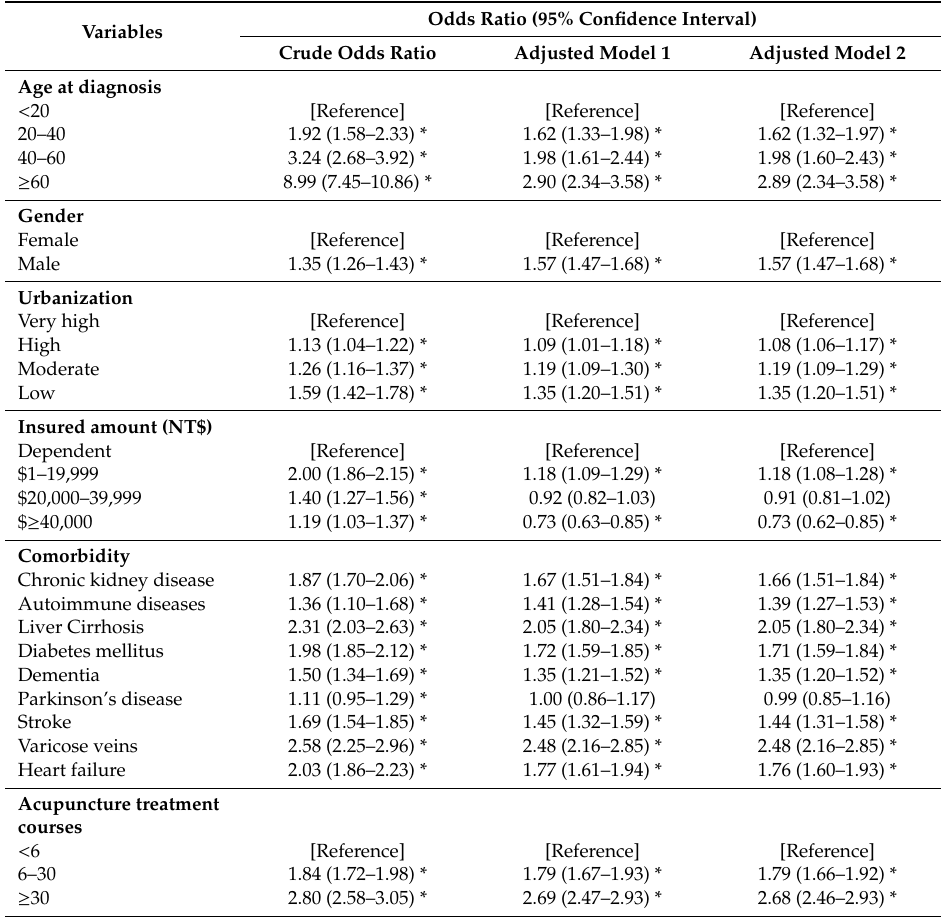
Table 2. The association between demographic / medical factors and cellulitis after acupuncture in all acupuncture groups.